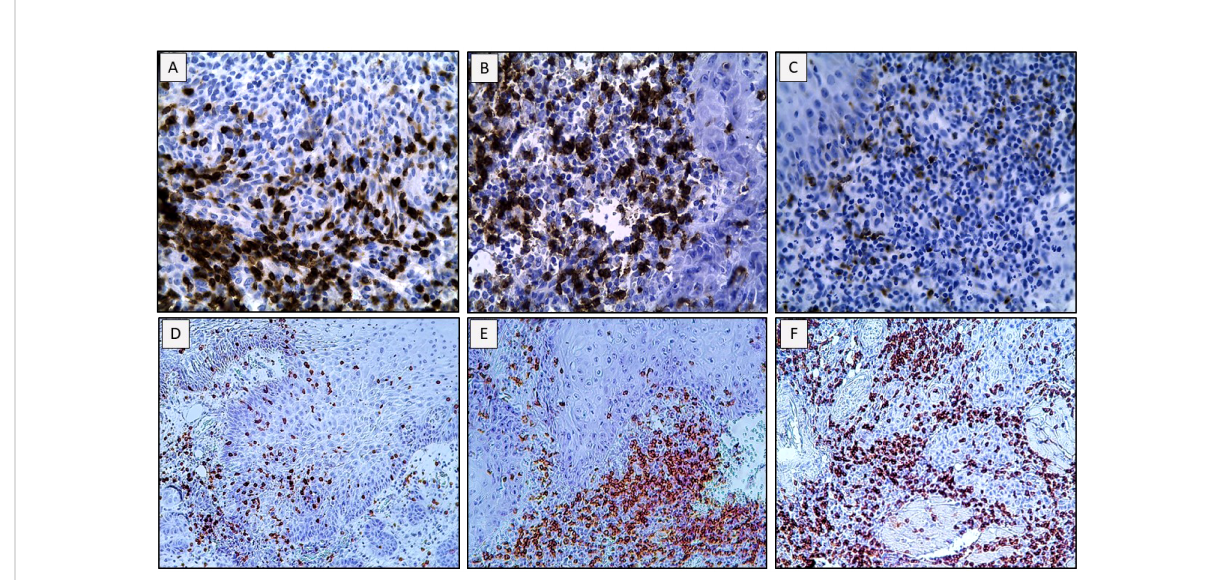
FIGURE 4 Representative pictures of immunohistochemistry images used to quantify CD3+, CD8+ and Granzyme B+ cells and to analyze their local distribution inside the tumor samples. (A) CD3+ cells; (B) CD8+ cells; (C) Granzyme B+ cells. Micrographs were obtained at 40x. (D) CD8+ cells located intratumorally in the center of the tumor or (E) CD8+ cells located mainly at the invasive margin; (F) in both the invasive margin and in the center of the tumor. Micrographs were obtained at